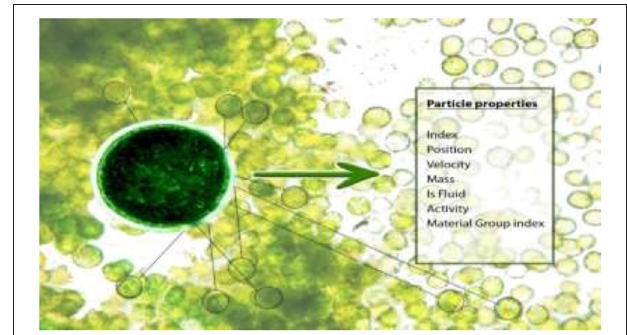
FIGURE 2 | Particle properties in position-based dynamics